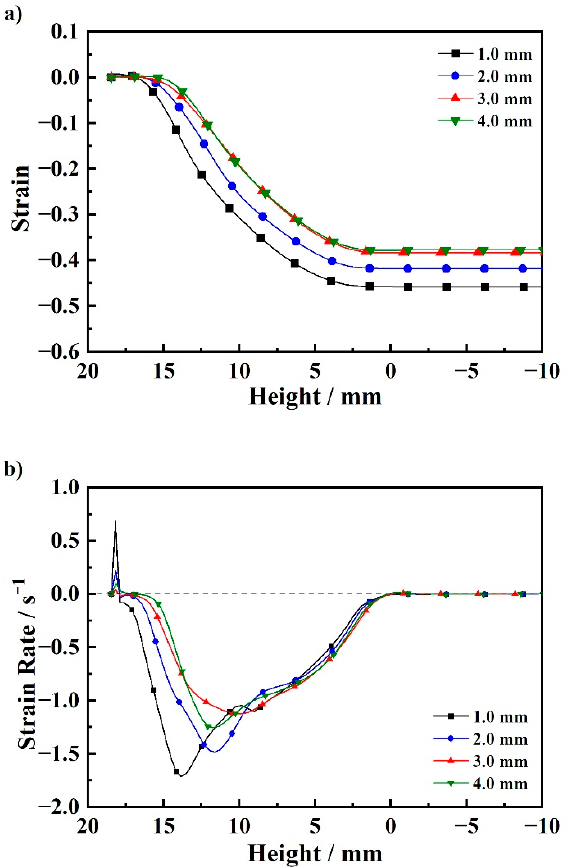
Figure 14. Curves of strain and strain rate of core in LSL-TRC with different core thickness. ( a ) Strain curves; ( b ) Strain rate curves.